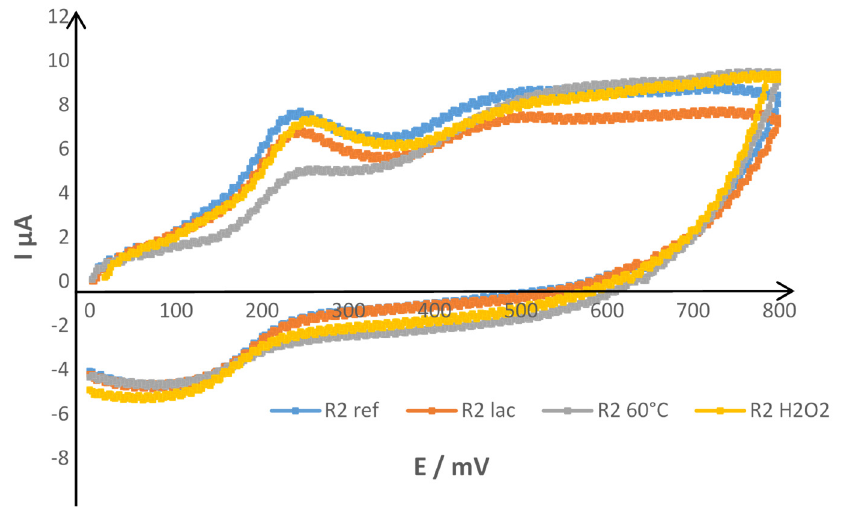
Figure 3. Cyclic voltammograms of R2 wine non-oxidized (ref) and oxidized with three different protocols: temperature protocols: temperature (60 ◦ C), chemical (H 2 O 2 ) and enzymatic (laccase) with (60 °C), chemical (H 2 O 2 ) and enzymatic (laccase) with SWCNT.